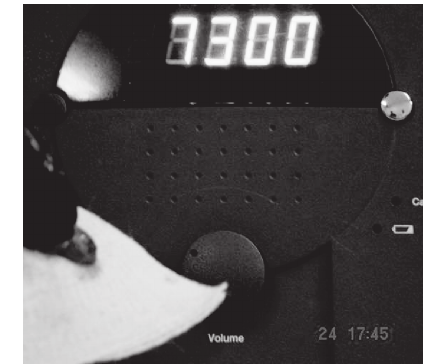
FIGURA 3 – Demonstração da atividade radioativa do linfonodo sentinela “ex-vivo”, também corado por azul patente.